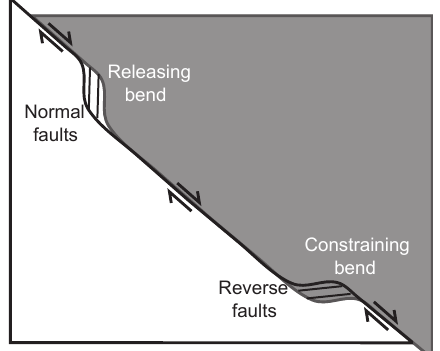
Figure 11. Diagram demonstrating how jogs in a strike-slip fault can cause both constraining and releasing bends. After right-lateral movement, normal and reverse faults are created at the releasing and constraining bends, respectively. The strike of the new faults will be close to that of the strike-slip fault, depending on the original jog angle. Effectively, it creates a system of normal and reverse faults with similar strike, along the strike of the strike-slip